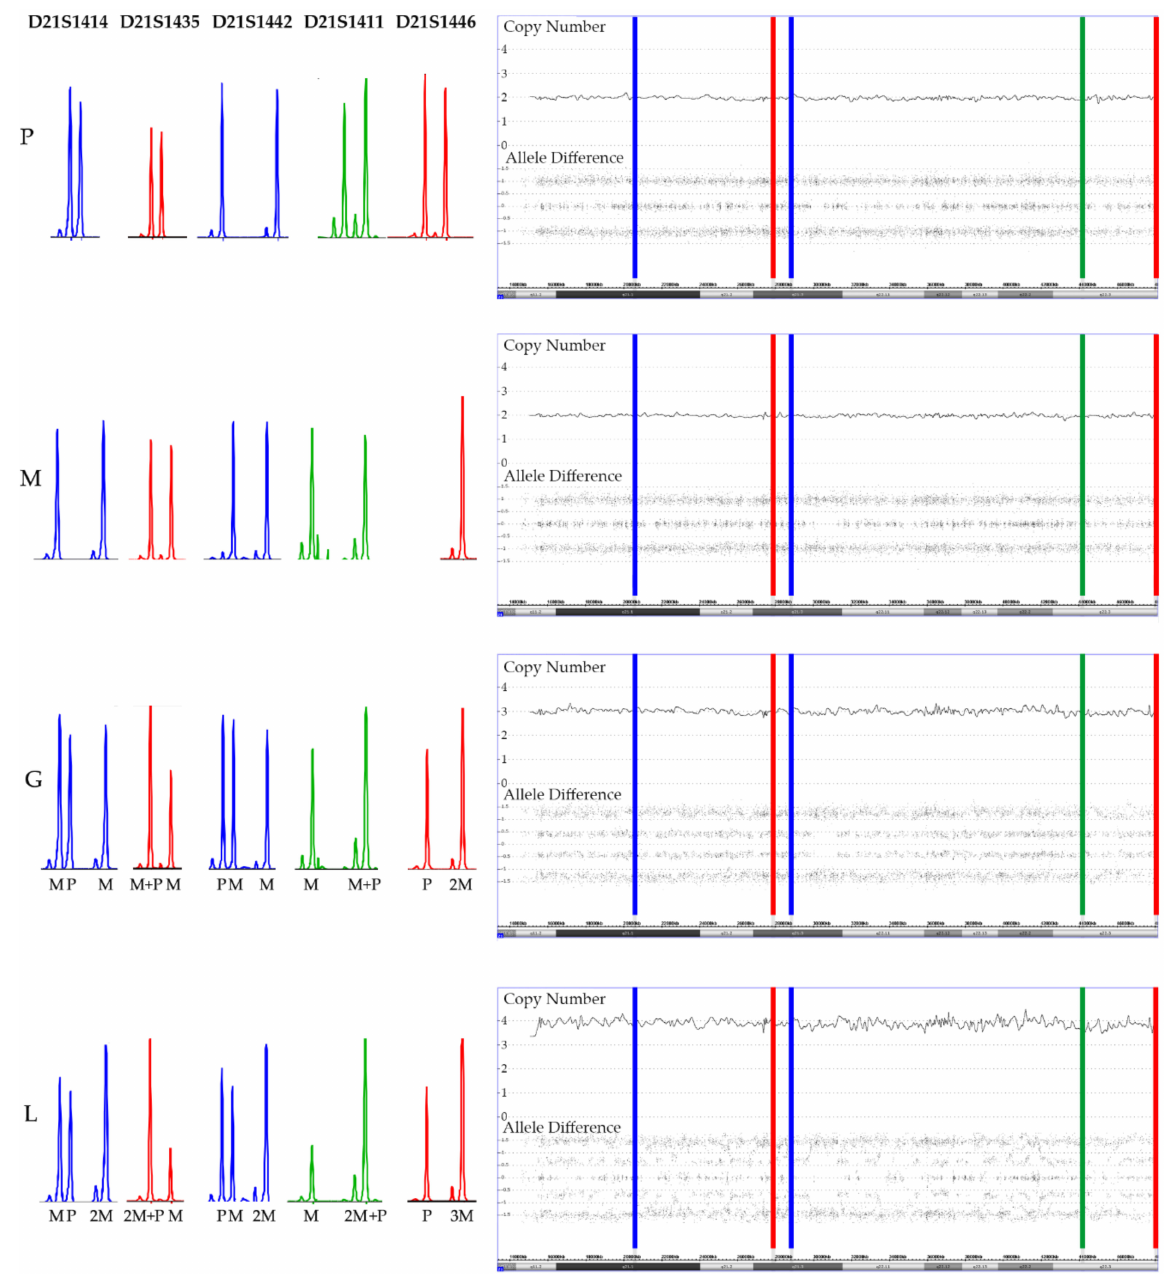
Figure 9. Add-on analyses of five short tandem repeat markers (STR) clarifies the parental origin (M: maternal, P: paternal) of the array-secured surplus chromosomes in the trisomic germline (G) and the tetrasomic leukemic cells (L) in a patient with a constitutional trisomy 21. The location of the five STR markers is marked in the array image in successive order. As evidenced by two peaks of a similar height, all paternal and four maternal markers are heterozygous and only the maternal D21S1446 marker is homozygous (only one but higher peak). Two of the markers are informative (D21S1414 and D21S1442) and clearly prove the maternal meiosis 1 origin of the extra chromosomes and, although it cannot be decided whether the three non-informative ones (D21S1435, D21S1411 and D21S1446) are uni- or biparental derived, their homozygosity is at least also compatible with this interpretation. The STR pattern of the leukemic cells not only prove that one of the maternal homologues is duplicated but also uncovers which of the heterozygous D21S1414, D21S1442, D21S1411 and D21S1435 alleles belong together and define it. What also becomes clear from this comparative analysis is that trisomies produce the same array allele distribution patterns, irrespective of whether they are composed of two (2 + 1) or three (1 + 1 + 1) distinct alleles. Copy number validation with a RUNX1 FISH probe unveiled that 25% of the leukemic cells had three and 75% four chromosomes